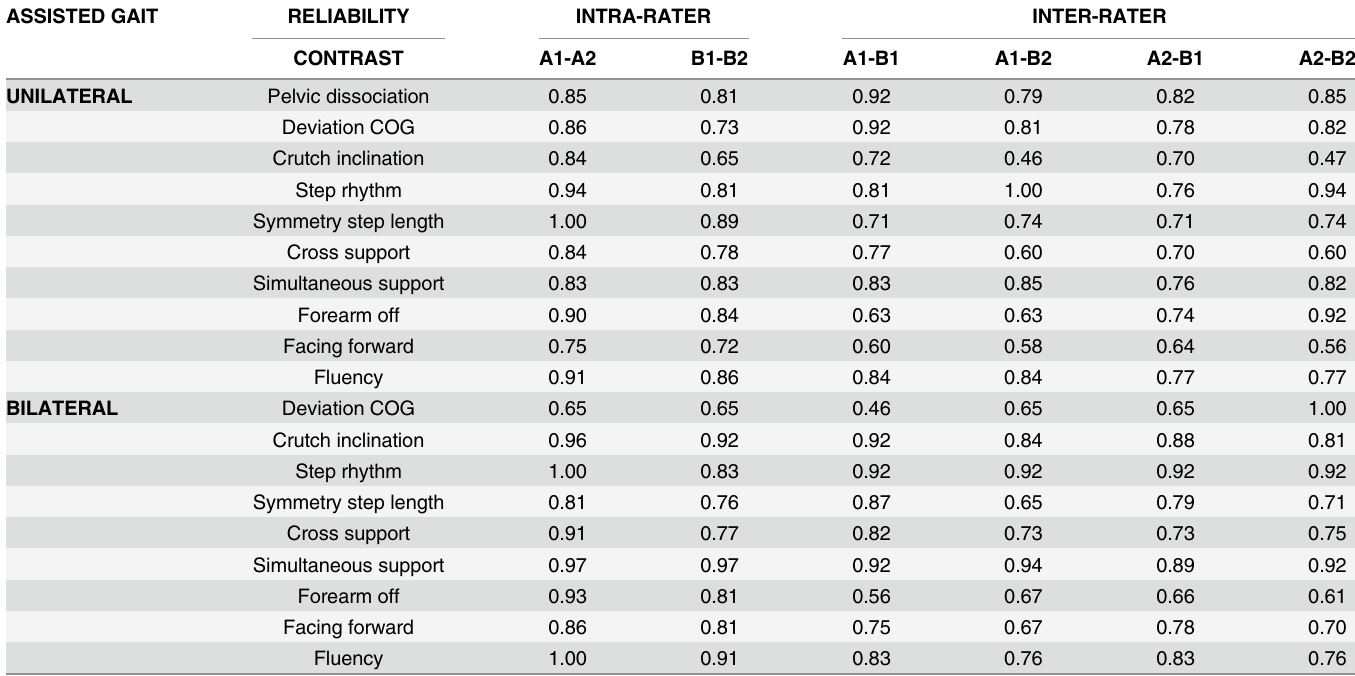
Table 2. Intra and inter rater reliability: weighted kappa coefficients for the CHAGS items in unilateral and bilateral conditions. ASSISTED GAIT